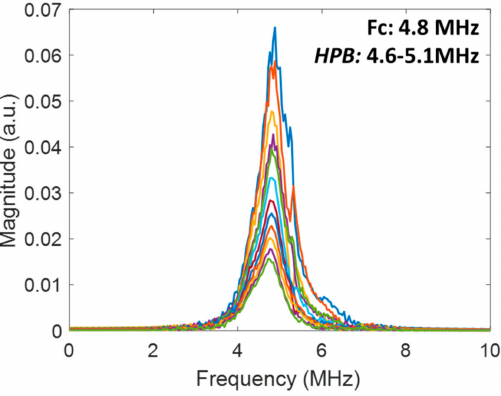
Figure 6. Acoustic wave responses (cid:104) S ( x i , f ) (cid:105) in the frequency